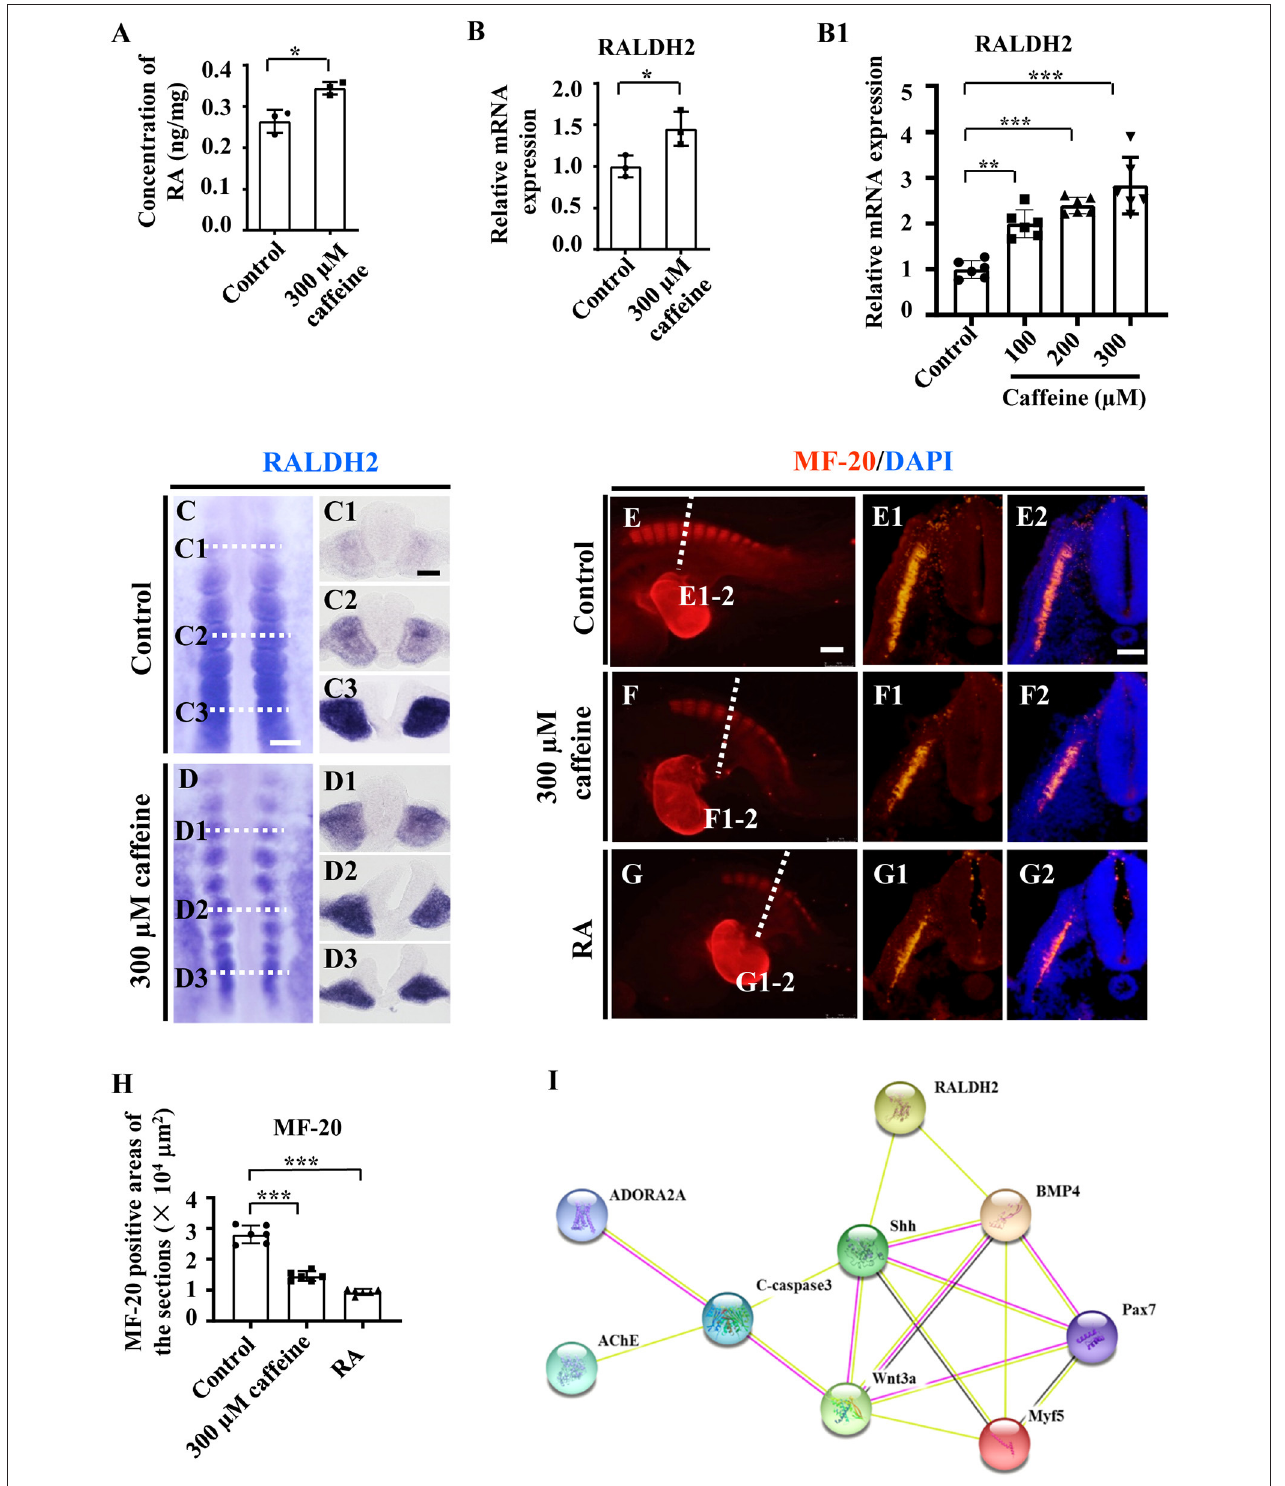
FIGURE 4 | Assessment of the somitogenesis-related gene expressions following caffeine treatment. (A) ELISA data showing the concentration of retinoic acid (RA) in the control and caffeine-treated groups of HH10 chicken embryos. (B,B1) Quantitative RT-PCR data showing the mRNA expression of RALDH2 from the control and